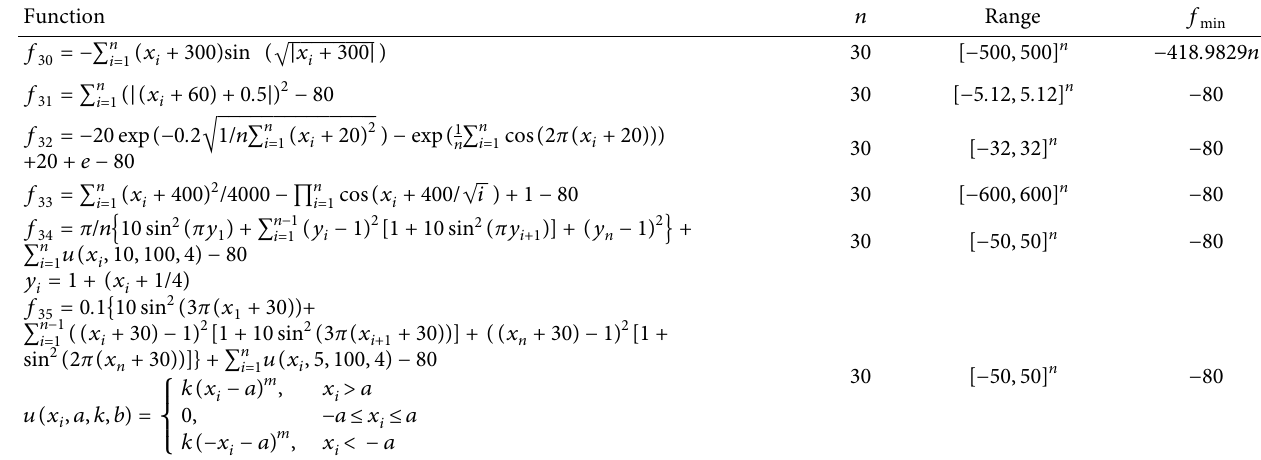
Table 5: Shifted and biased multimodal benchmark